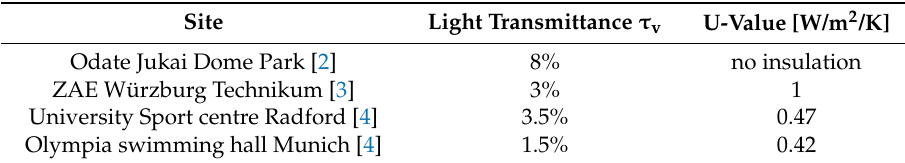
Table 1. Optical properties of other multilayer membrane roofs.